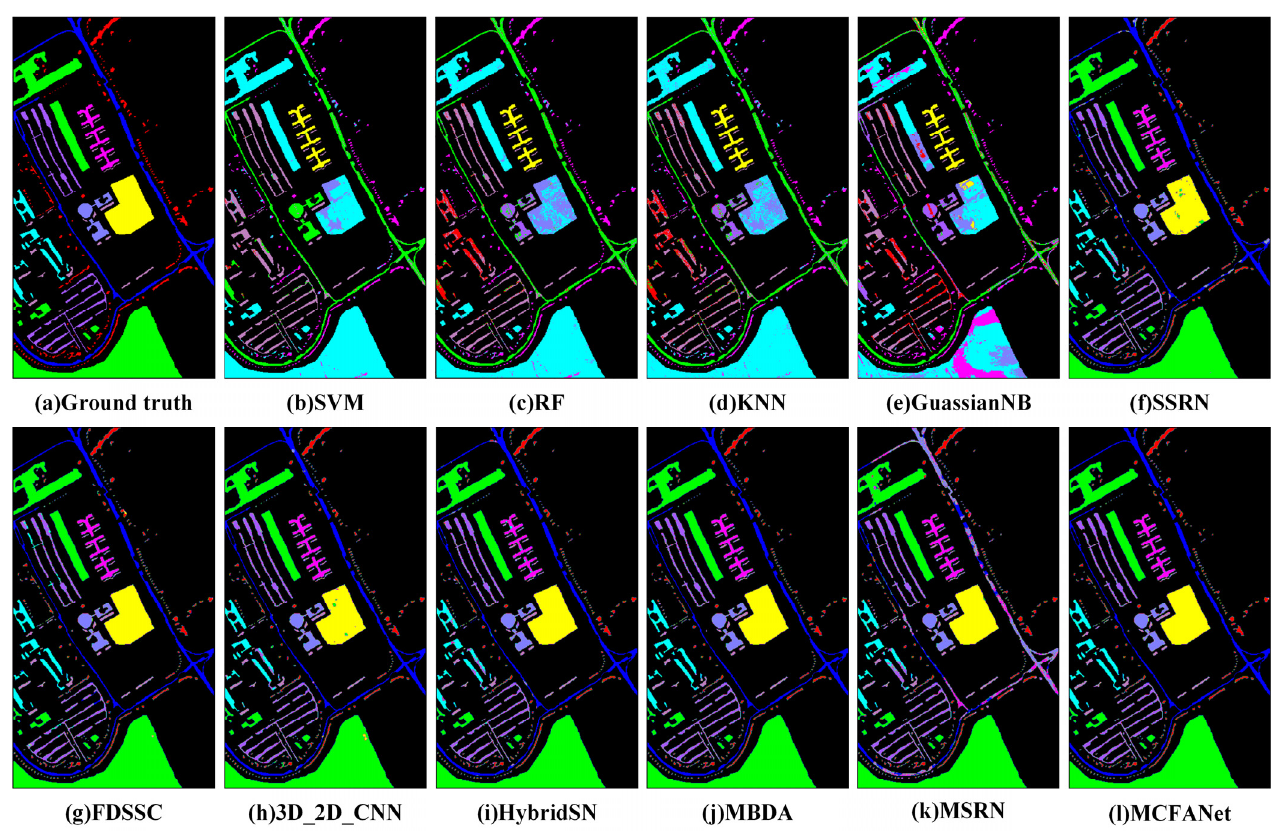
Figure 12. The visual classification maps of diverse approaches on the UP dataset.